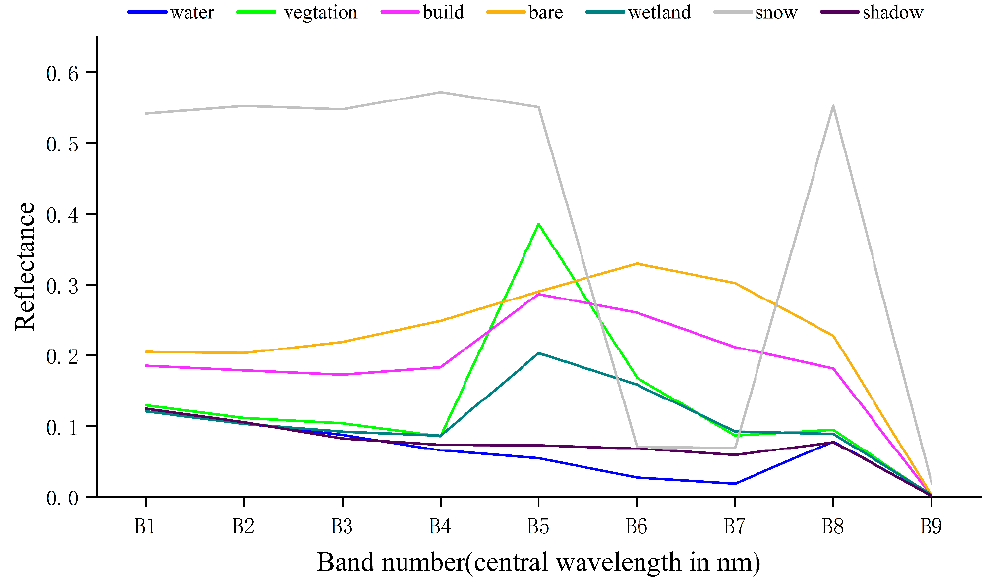
Figure 4. Spectral reflectance characteristics of typical ground objects in the study